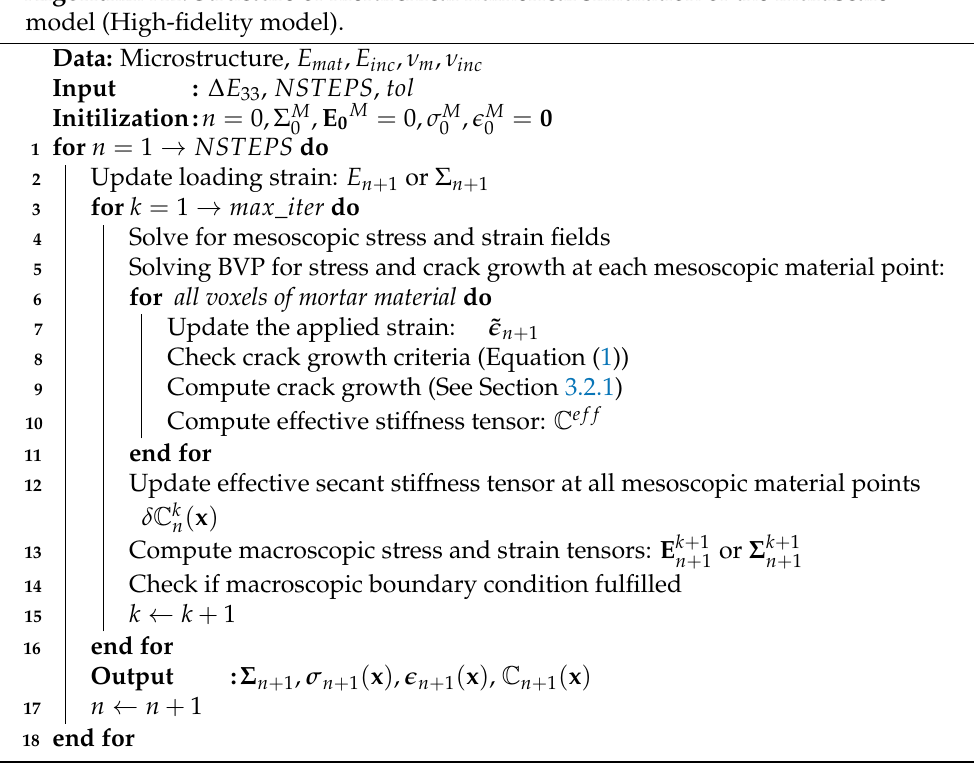
Algorithm A1: Structure of hierarchical numerical simulation of the multiscale model (High-fidelity